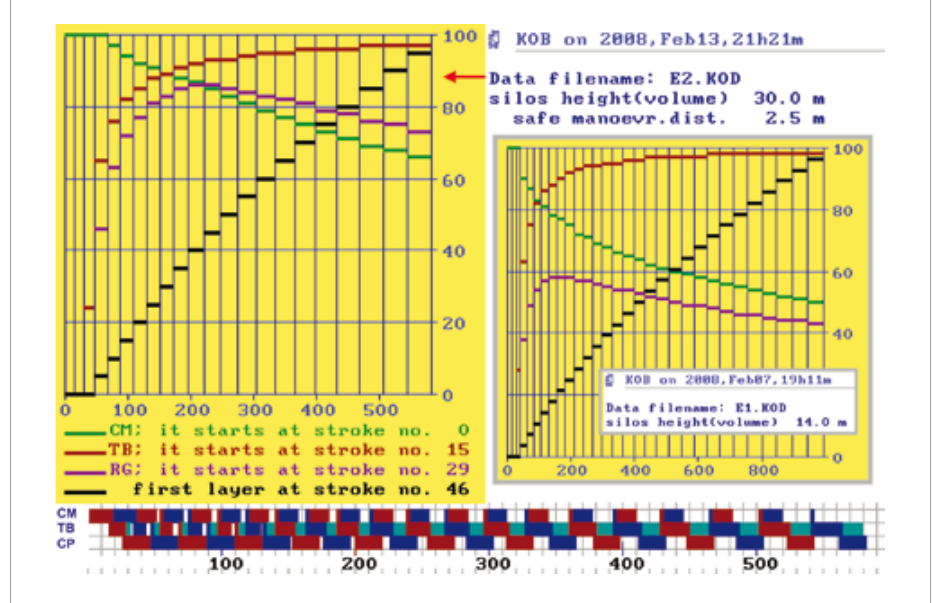
Fig. 6. Percentage of occupancies of elements CM, TB,